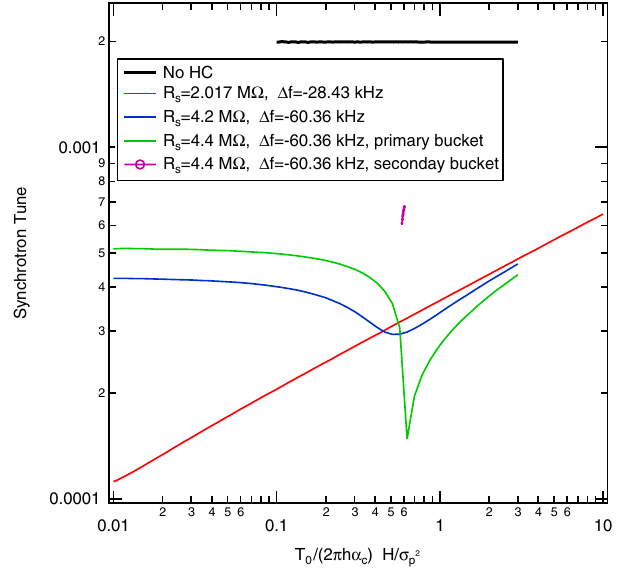
FIG. 8. Synchrotron tune as a function of the (normalized) Hamiltonian for various settings of the harmonic cavities. The (nearly constant) curve corresponding to the case without harmonic cavities is also shown for comparison.